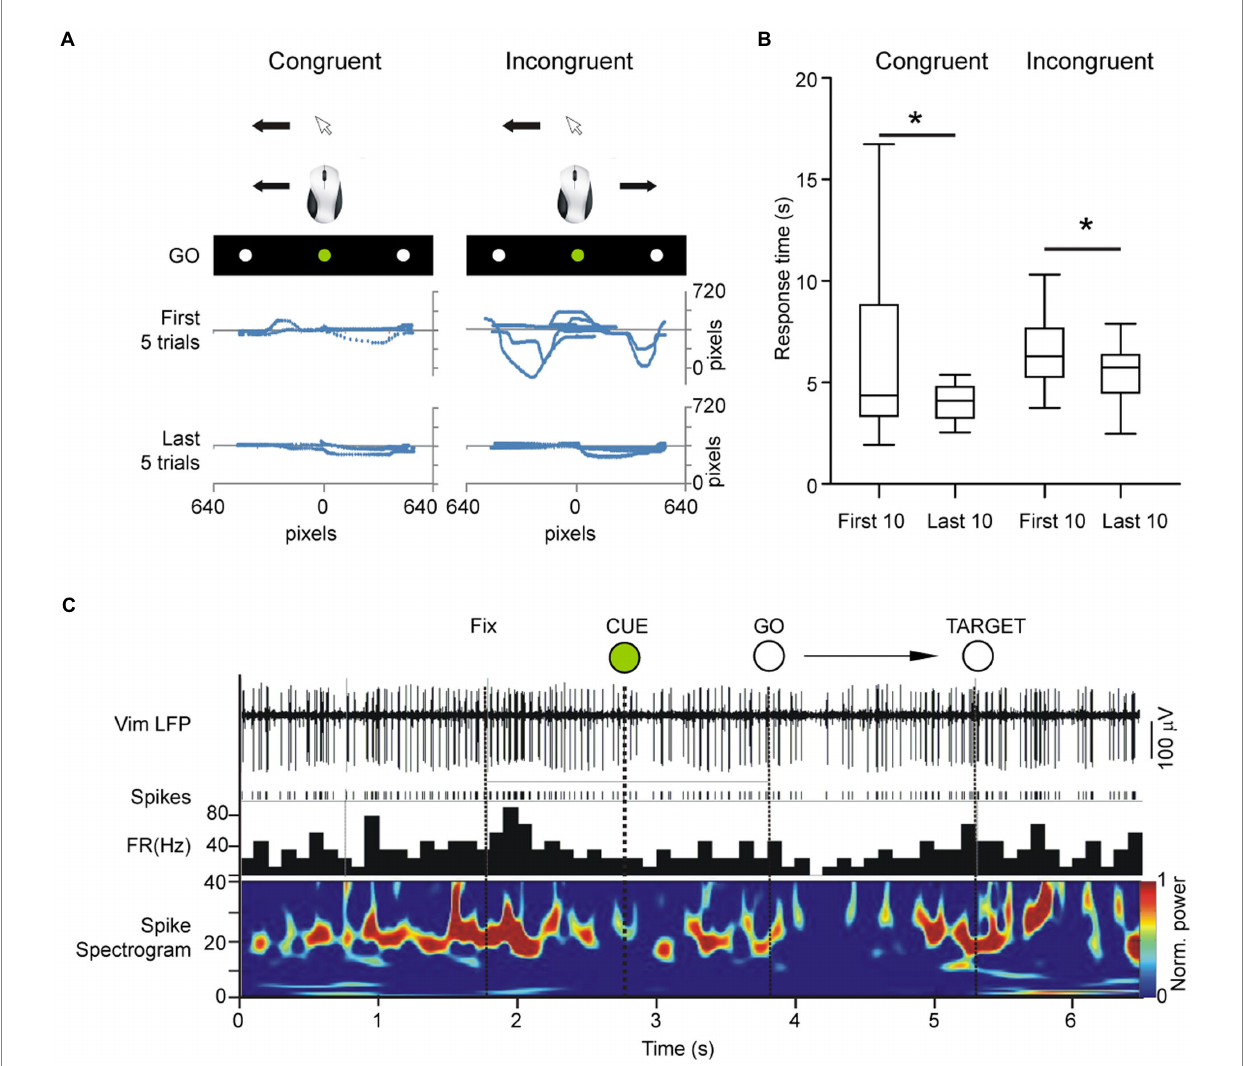
FIGURE 2 Center out task was shown to patients on an LCD monitor mounted over the patient in the operating room in a supine position and adjusted for full visibility. Due to restrictions imposed by the stereotactic frame, we opted to only investigate horizontally cued movements. The patient’s head was fixed toward the visual stimuli but moved the mouse on a flat surface without visual guidance of the hand/mouse movements. (A) Cursor traces of center-out movements in the first 5 and last 5 trials in the congruent and incongruent task, respectively. (B) Response times in incongruent versus congruent tracking tasks. Total time of response from center to periphery improved in both congruent and incongruent orientations. (C) Example local field potential of the Vim during the center-out task showing rhythmic multi-unit activity in the beta band and desynchronization of rhythmic firing during the